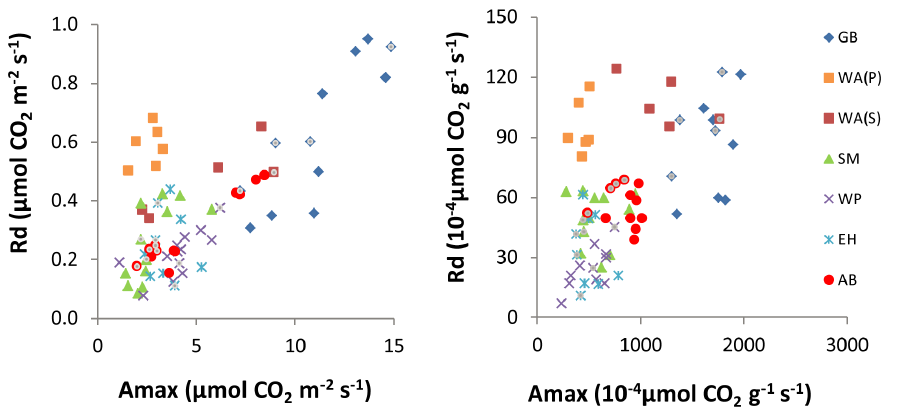
Figure 2. Relationships between Amax and Rdark. The left panel shows area-based rates, and the right panel shows mass-based rates. Symbols marked by small grey dots indicate shade leaves of sun grown trees. Species code: GB=gray birch, WA(P)=white ash sampled at the Princeton site,